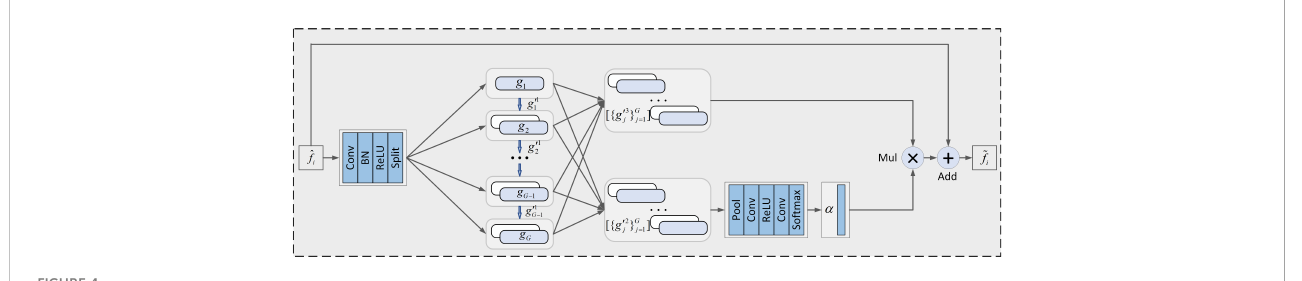
FIGURE 4 The structure of the HMU